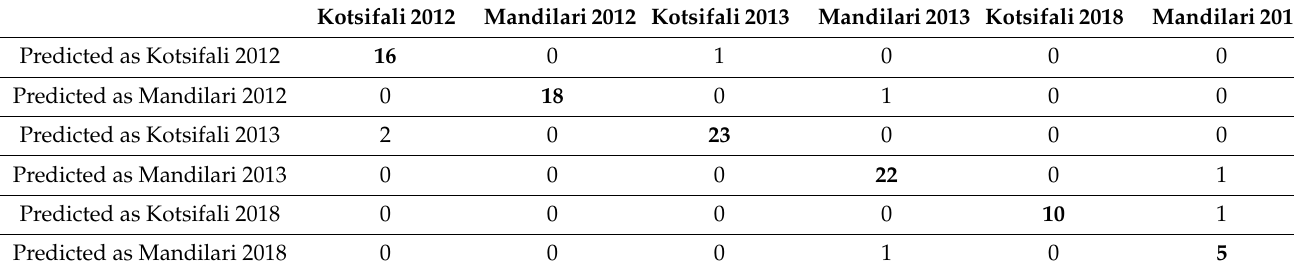
Table 2. Classification of red grape varieties (2012, 2013 and 2018 vintages) with